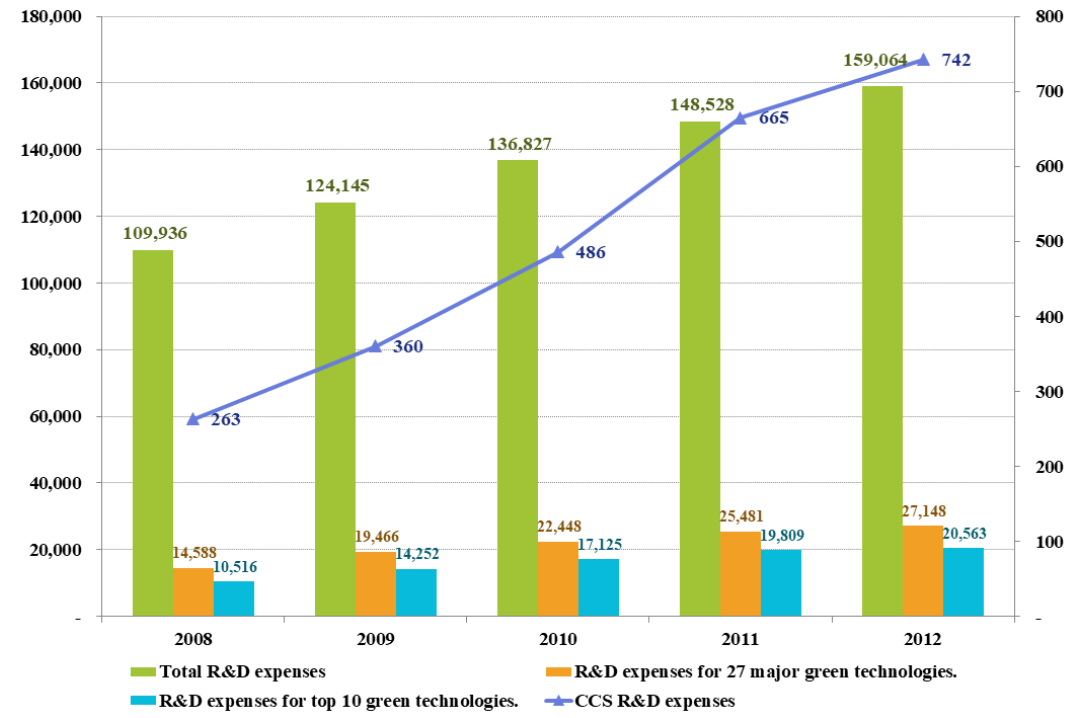
Figure 2. Green Technology Investment (2008–2012) (data from Green Technology Center, 2013). Twenty-seven key green technologies were presented in the Five-Year Green Growth Plan announced by the Korean government in 2009. Ten core green technologies were further revealed in the seven tasks for green growth announced in 2010, along with a plan to promote new growth engines. The ten core green technologies include secondary batteries, future nuclear power, advanced water treatment, CCS, smart grids, LED lighting displays, green IT, solar cells, green cars, and fuel cells. Figure 3 shows the investment trends of 27 major green technologies from 2008 to 2012